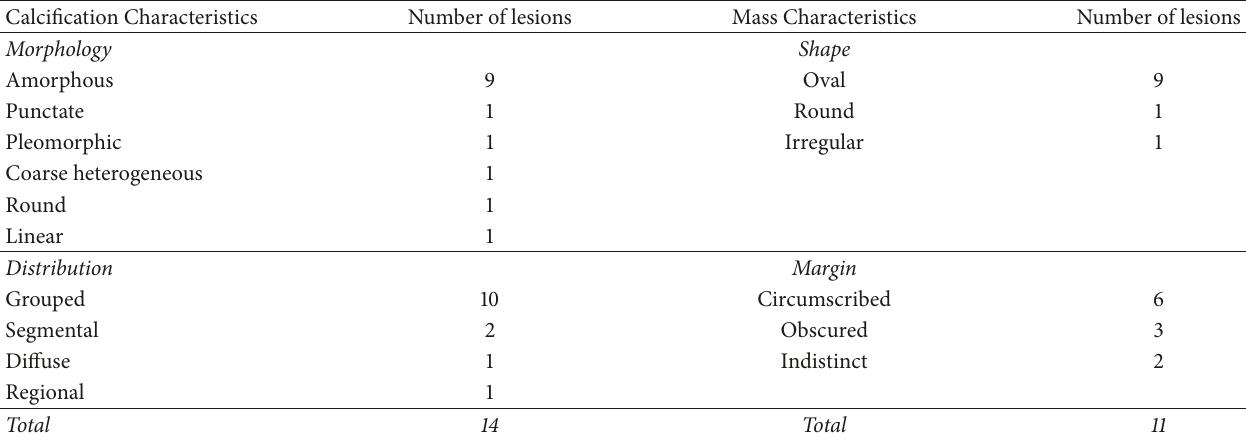
Table 1: Mammographic